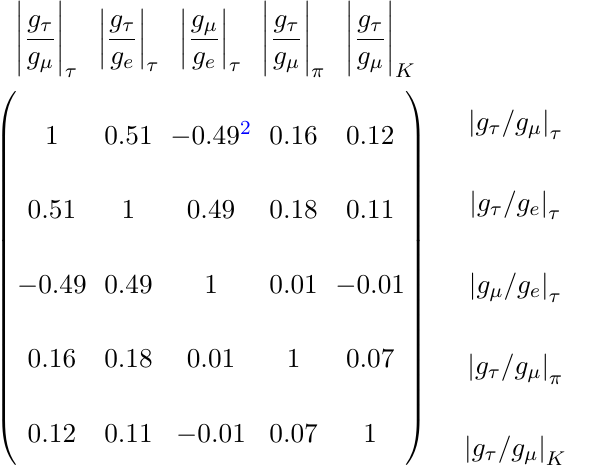
Figure 7. Tree-level diagrams generating ‘ → ‘ 0 νν , in the type-I seesaw. g ν‘ coupling defined in eq. (2.28) and S